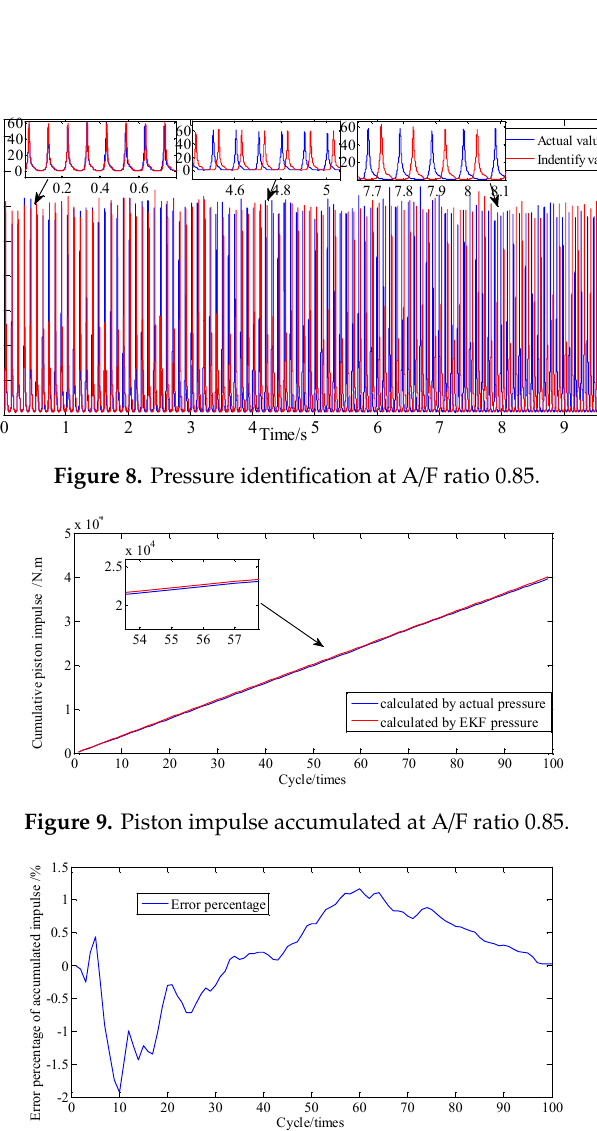
Figure 6. Speed tracking at A/F ratio 0.85. Figure 7. Error percentage of speed tracking at A/F ratio 0.85. Once the optimal speed from the EKF engine model is predicted, the peak pressure of cylinder can be calculated. Furthermore, the 24th order FAMFS is adopted for identification purposes, and its parameters are shown is Table 2: Table 2. Parameters of the 24th order Fourier series. a0~a6